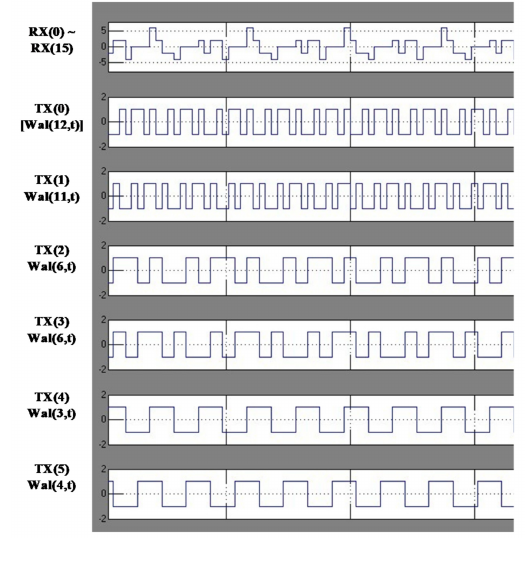
Figure 23. Transient simulation results of the 16th AFE channel.